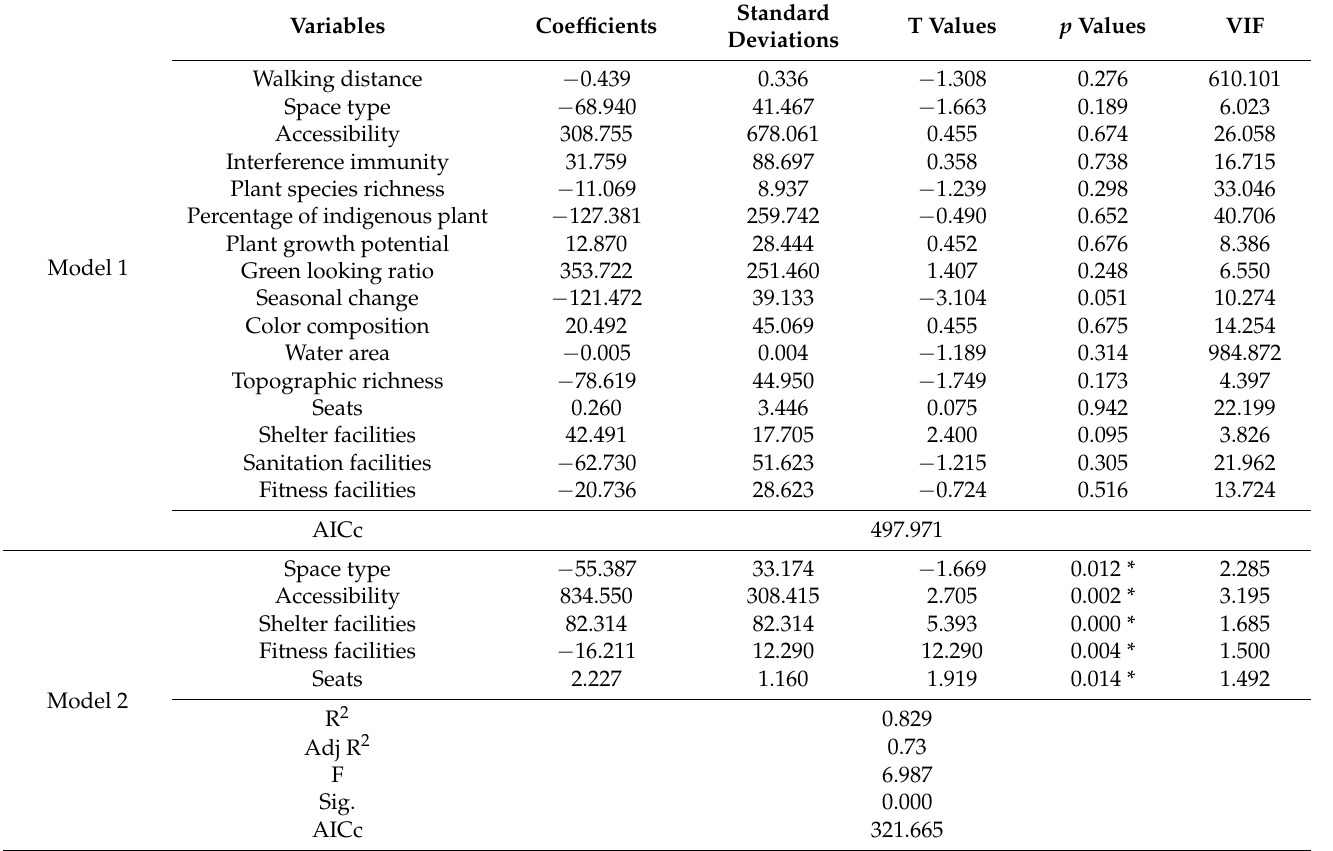
Table 4. Results of the Linear Regression Analysis—Residents. * p <